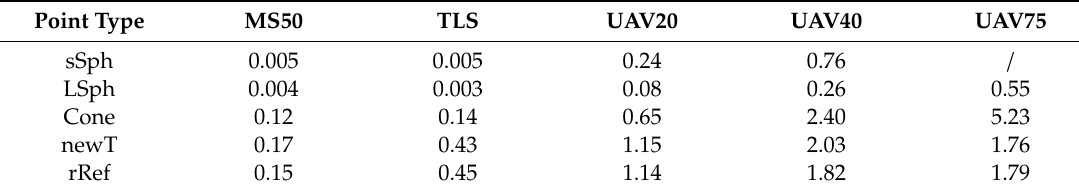
Table 5. Three-dimensional precision of coordinates of reference target points (in